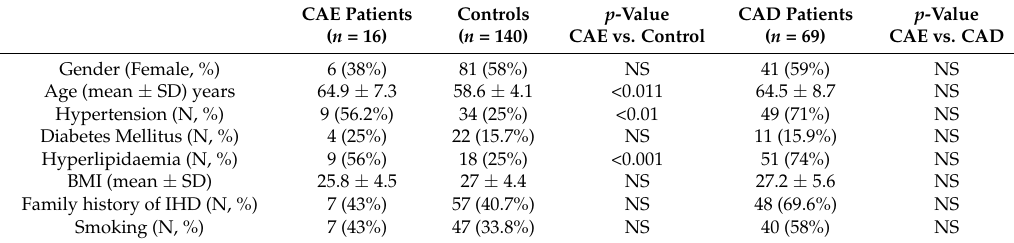
Table 1. Demographic characteristics and cardiovascular risk factors of coronary artery ectasia (CAE) group and